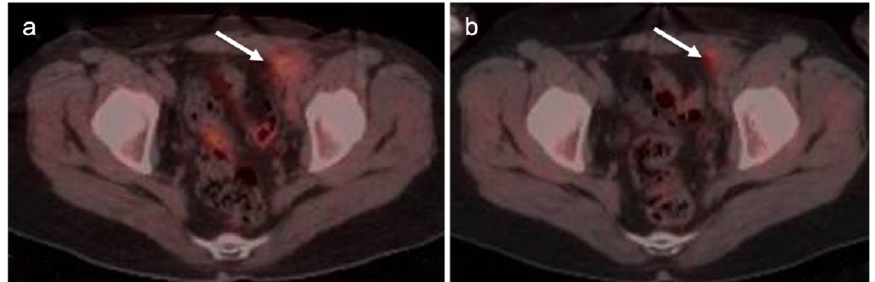
Figure 43. Pre- ( a ) and post-treatment ( b ) FDG PET-CT scans in a mixed germ cell tumor (white arrows) show a reduction in size following treatment but residual metabolic activity in the left inguinal mass. Subsequent stability in size over a long interval supported that no residual viable tissue was present post-treatment, despite residual metabolic activity.